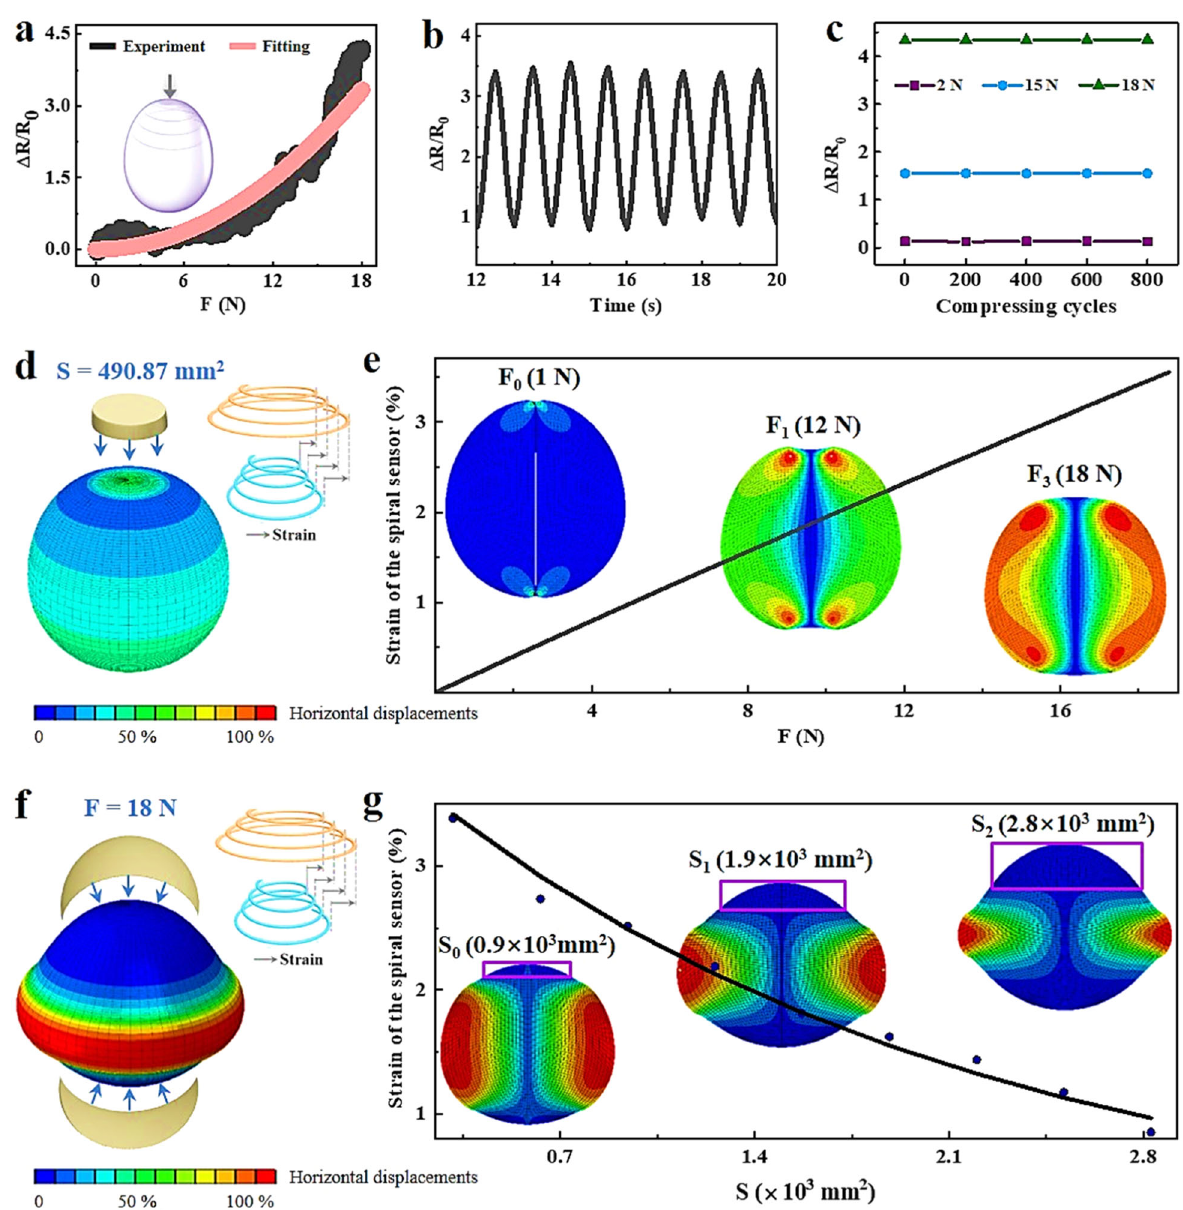
Fig. 4 Performance and mechanism of the grip strength monitoring. a Resistance changes versus different forces of the smart ball sensor. b Cyclic performance (1 Hz, 17.7 N) and c stability under various levels of force. Under a contact area of 490.87 mm 2 , d the 2D loading model and e FEA results of the strains of the spiral sensor versus different compressing forces. Under a compressing force of 18 N, f the 3D loading model and g FEA results of the strains of the spiral sensor versus different 3D contact areas. The spiral sensor (diameter 45 mm × width 2 mm × thickness 0.075 mm, 4 circles, 1% laser speed, 0.3% power, 400 PPI), the egg-shaped ball model (width 3.8 cm × height 5.8 cm), and the indenter (diameter 25 mm × height 3 mm) were used Overall, substituting Eq. (7) into Eq. (6), the fi nal equation of the However, in the actual handgrip monitoring, the 3D contact grip strength in the way of F ¼ F Δ R = R 0 ; l ð area is dif fi cult to measure. To address this, we proposed to measure the arc length when grasping the ball to determine the 3D contact area between hand and ball. The relationship between 3D contact area and arc length could be obtained by the following equation: where a ¼ 1 : 03 ´ 10 (cid:2) 2 N (cid:2) 2 and b ¼ (cid:2) 4 : 8 ´ 10 (cid:2) 4 mm (cid:2) 2 are the fi tting parameters from Eqs. (1) and (3). S indenter is a constant of 490 : 87mm 2 in Fig. 4, but other mini-ball sensors may have a different S indenter when a smaller or larger indenter is used to where r is the radius of the lower part of the ball and l is measured compress the ball. In actual grip strength detection, it needs to arc length. Details about the arc length method can be found in measure the arc length under grasping, and then a cellphone Supplementary Figs. 10 and 11. could calculate the grip strength according to Eq. (8). This smart